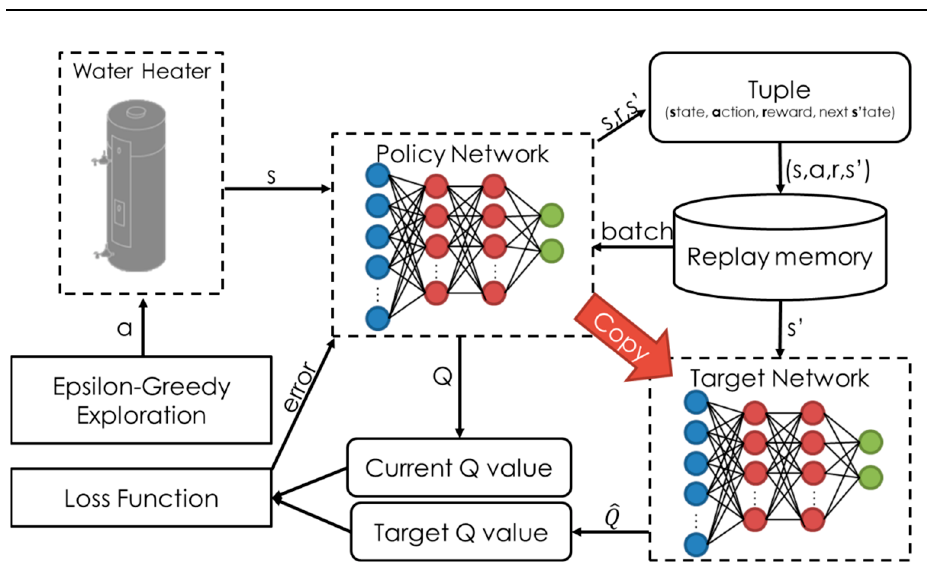
Figure 3. An overview of the DQN